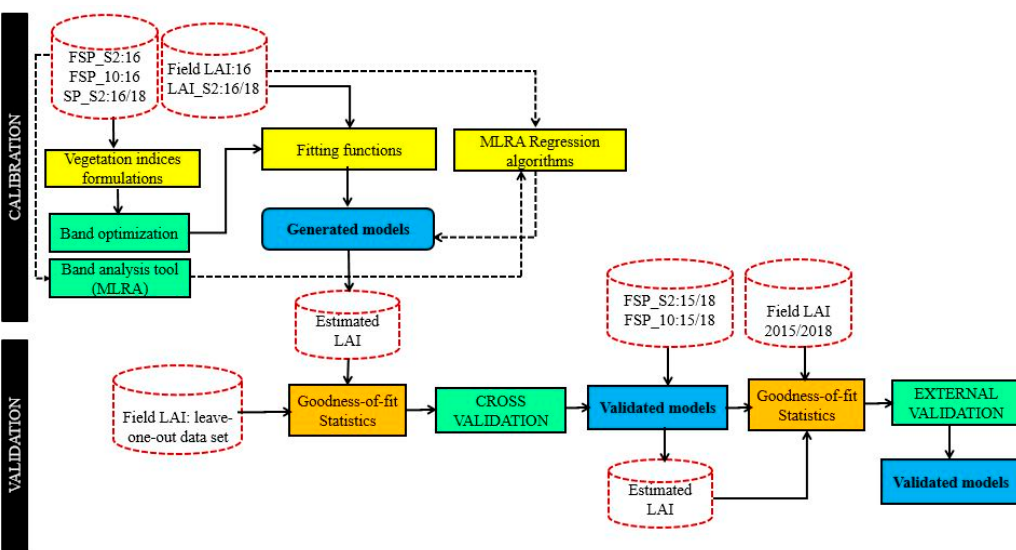
Figure 3. Statistical modelling process with the leaf are index (LAI) and spectral data used in the calibration and validation. In the calibration section, the full line arrows indicate the process for the vegetation indices approach while the dashed arrows indicate the process for the machine learning